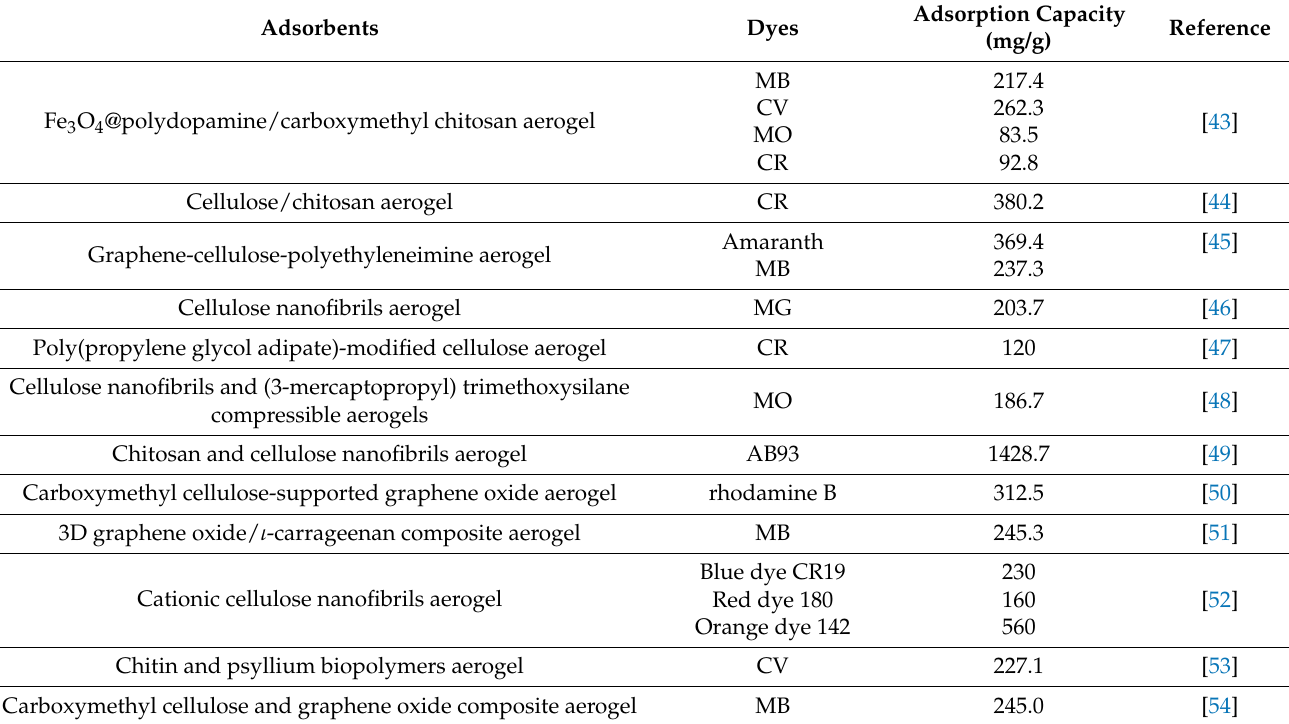
Table 1. Comparison of the adsorption effect of the present work with other types of aerogel adsorbents.